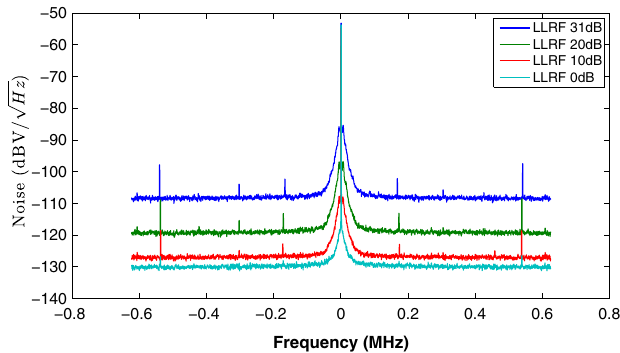
FIG. 16. Noise PSD at the rf feedback output as a function of controller gain. The rf input is